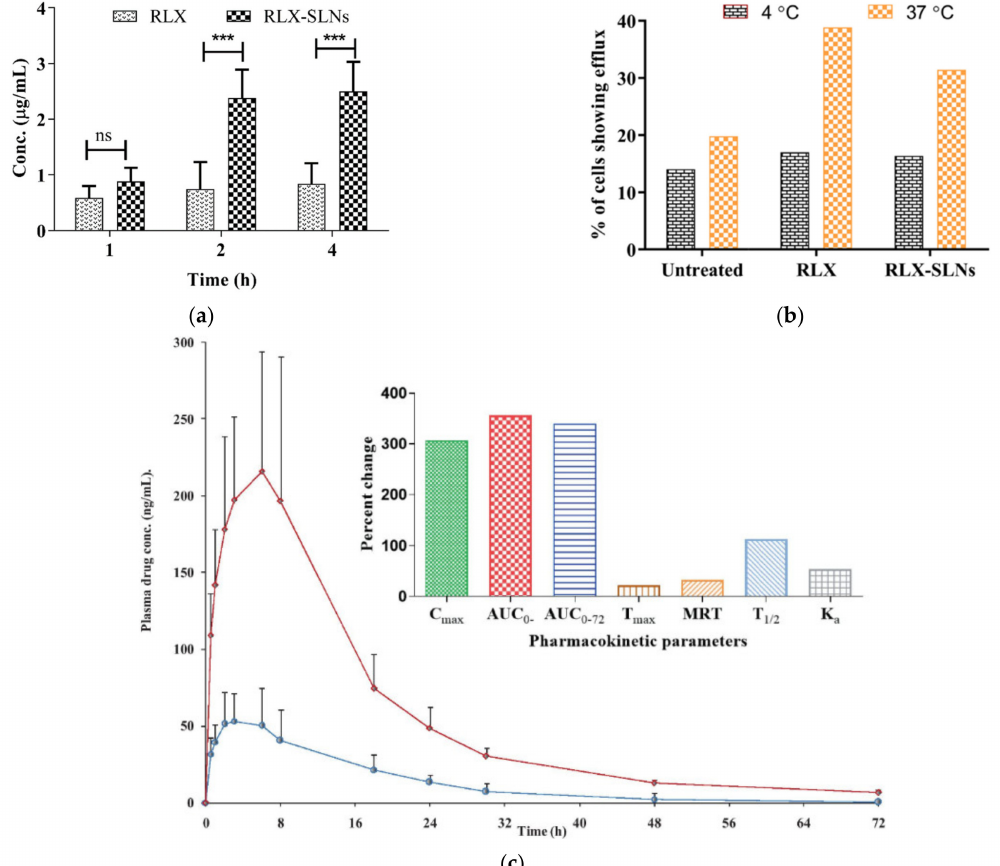
Figure 4. Effects of raloxifene (RLX)-loaded SLNs on ( a ) Caco-2 cellular uptake, ( b ) P-gp efflux using the Chemicon MDR dye efflux assay kit, and ( c ) pharmacokinetic properties of RLX (red curve: RLX-loaded SLNs and blue curve: RLX suspension). *** p <0.001, ns, not significant. Reprinted by permission from Springer Nature, Drug Delivery and Translational Research [87], Copyright ©